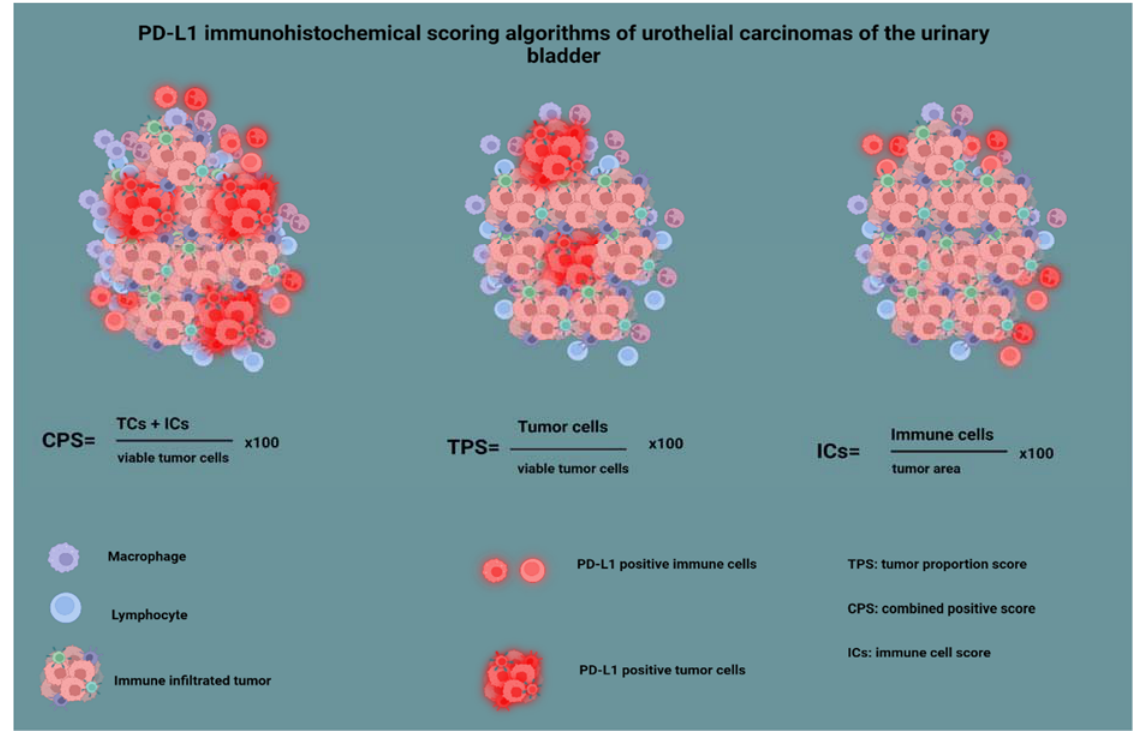
Figure 2. PD ‐ L1 immunohistochemical scoring algorithms of urothelial carcinomas of the urinary